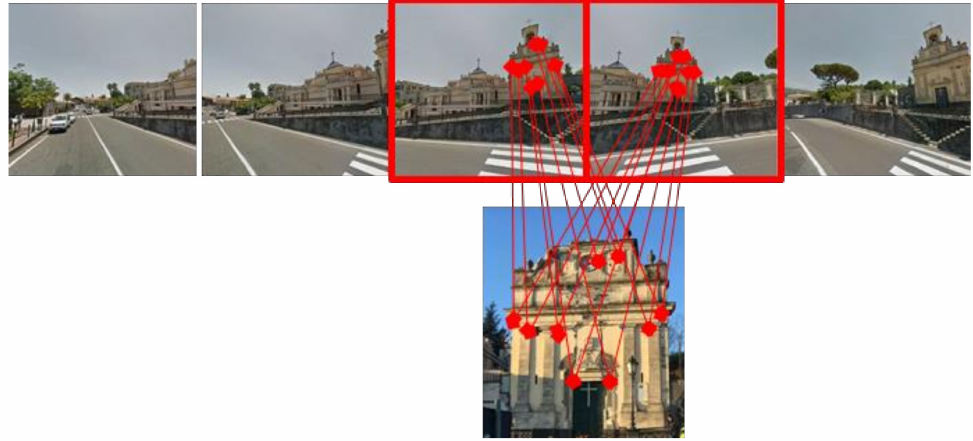
Figure 17. Result of the matching procedure applied to the image posted by the user and the image sequence extracted from Street